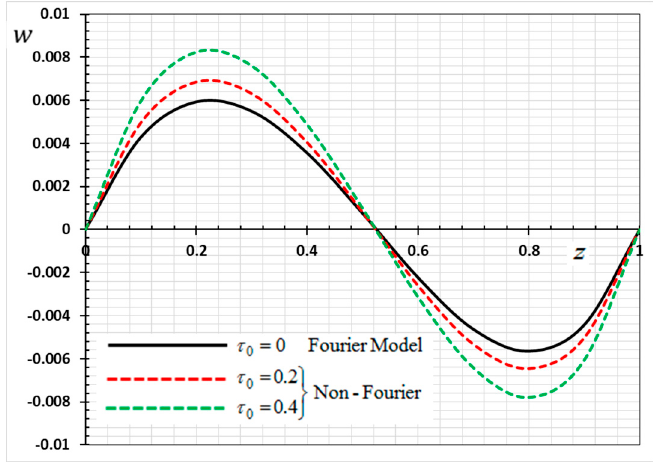
Figure 18 . Variation of displacement w versus z for Fourier and non-Fourier models.